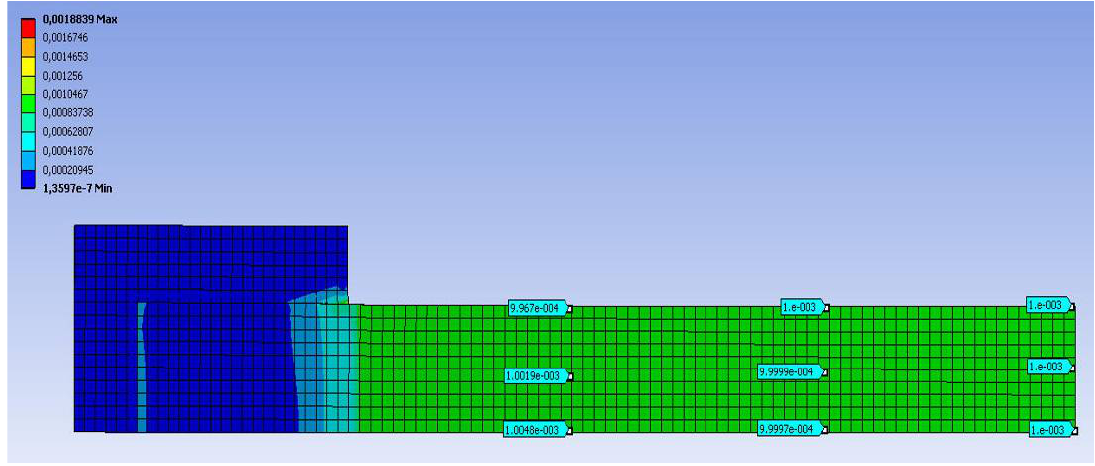
Figure 7. FEM strain analysis. The image shows a quarter of the specimen; results of other three quarters are identical due to the double symmetry of the